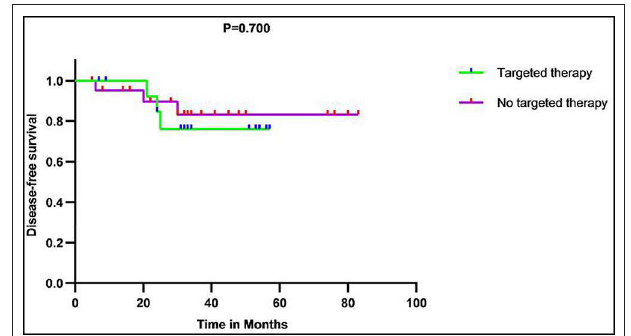
FIGURE 7 | Disease-free survival (DFS) curves showed there was no significant DFS difference between patients with and without targeted therapy in 37 patients with primary tumor in our